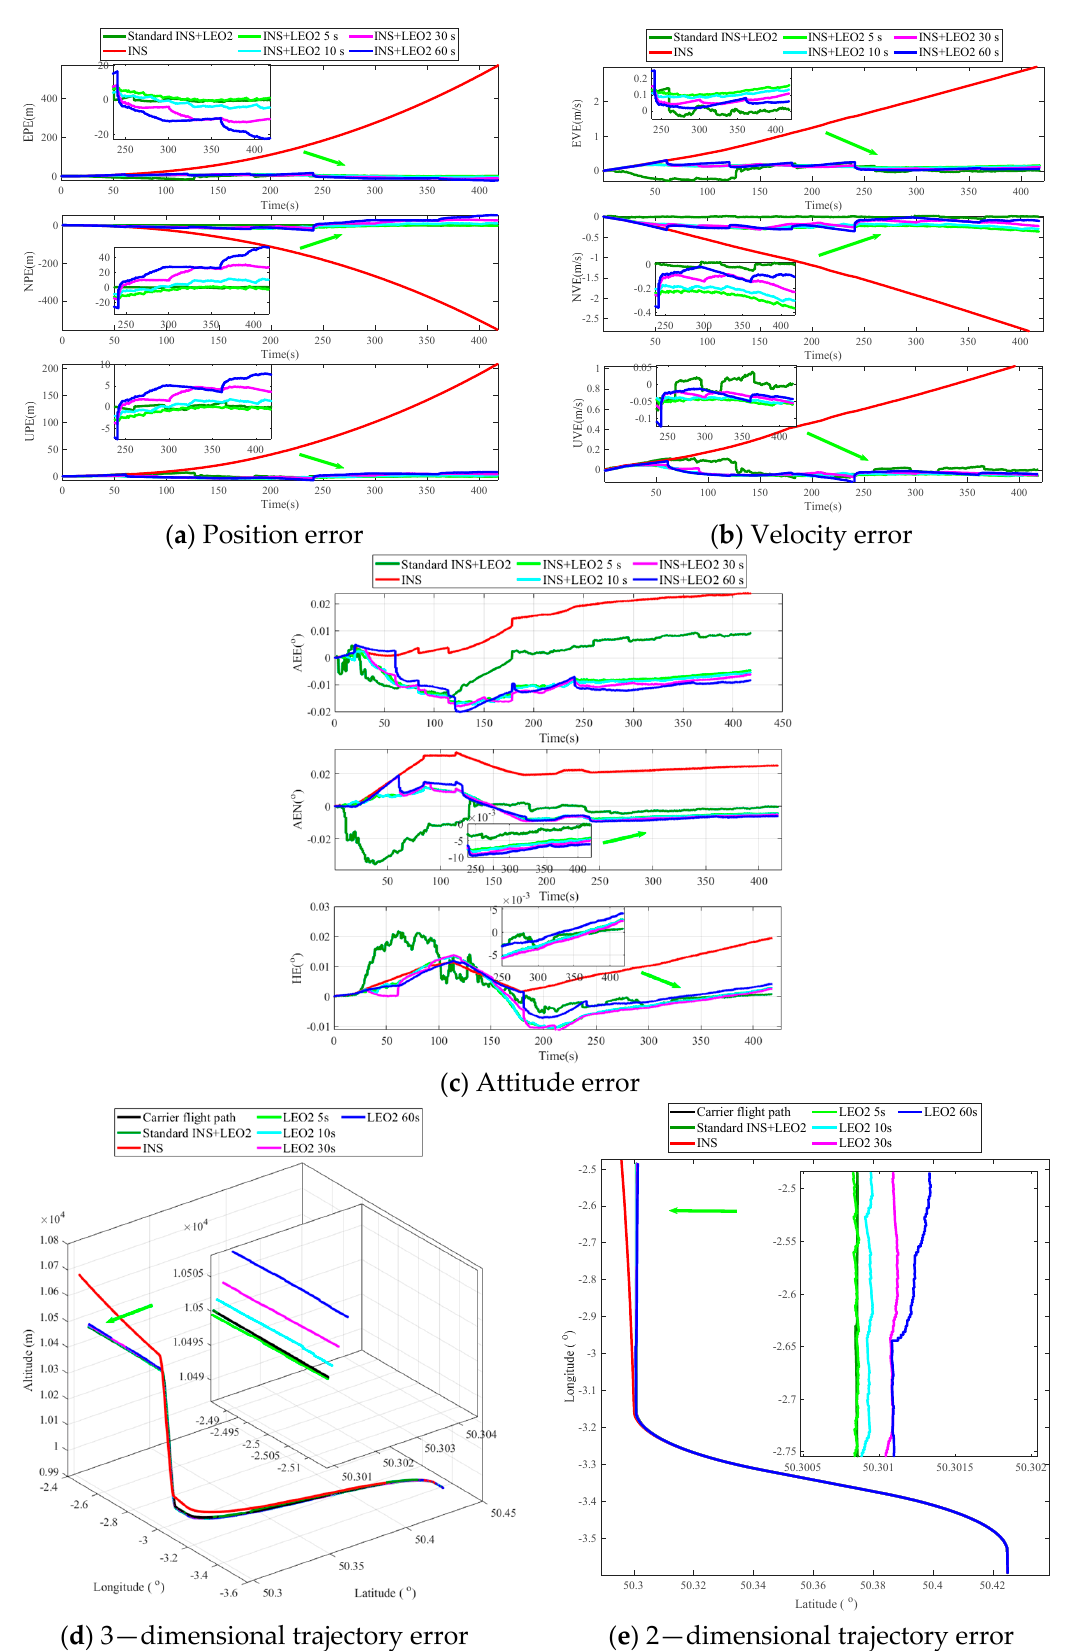
Figure 5. Error curve of the INS+LEO2-alternate switching ranging integrated navigation algorithm based on adjacent orbit surfaces.